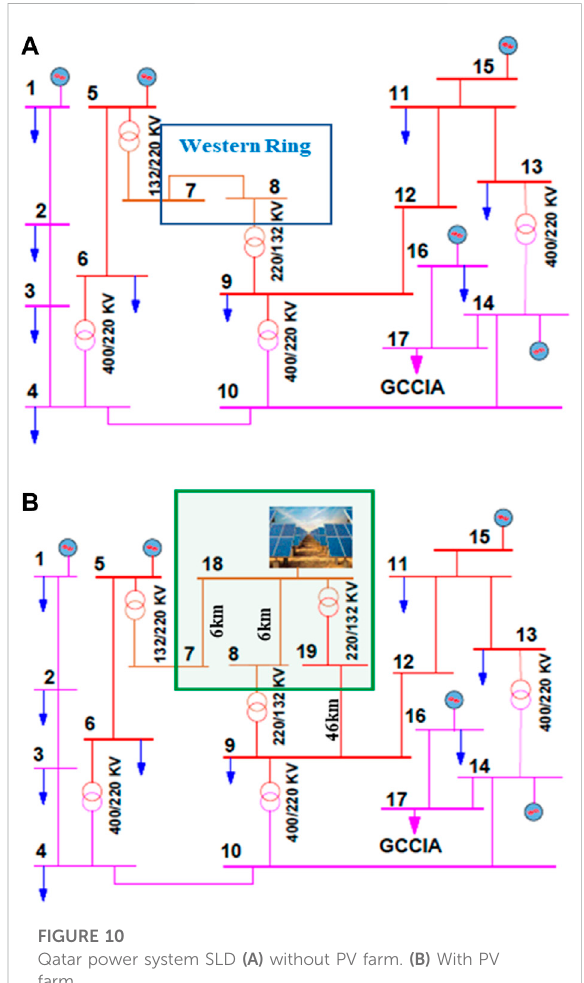
FIGURE 10 Qatar power system SLD (A) without PV farm. (B) With PV